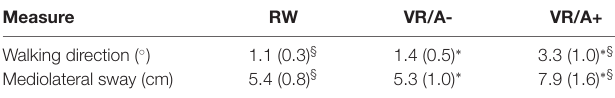
TABLE 3 | Walking direction and mediolateral